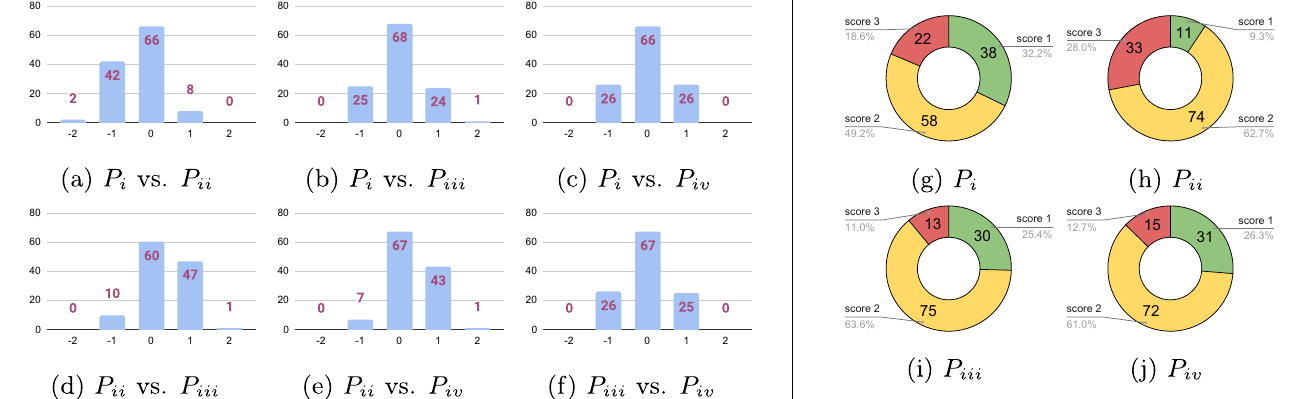
Fig. 6 Comparison of pleomorphism scores in the slide-study. The comparison of the pleomorphism scores of the four pathologists a – f as well as the score distribution of the pathologists g – j in the slide-study display the scoring patterns of the pathologists on the 118 whole-slide images in the slide-study. The largest differences were observed between P ii and other pathologists, with P ii assigning signi fi cantly lower number of score 1s and much higher number of score 3s compared to the other three pathologists.